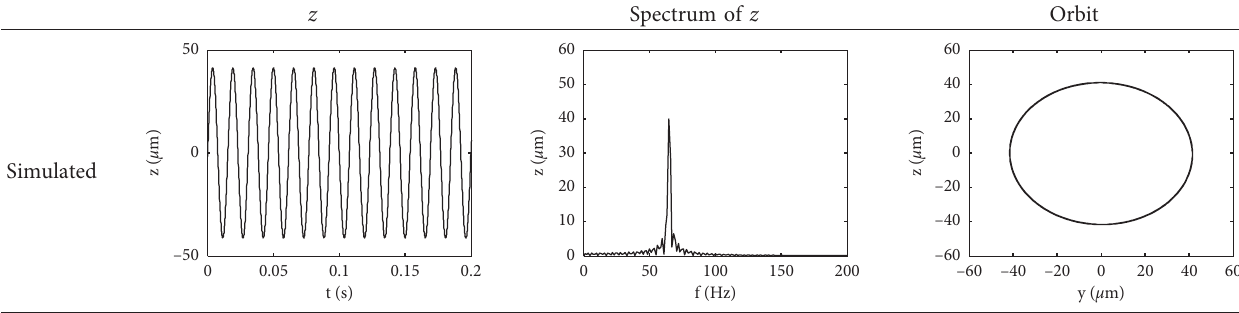
Table 6: Comparison of the vibration responses under support 2 upward 1mm condition ( h � 1mm). z Spectrum of z Orbit